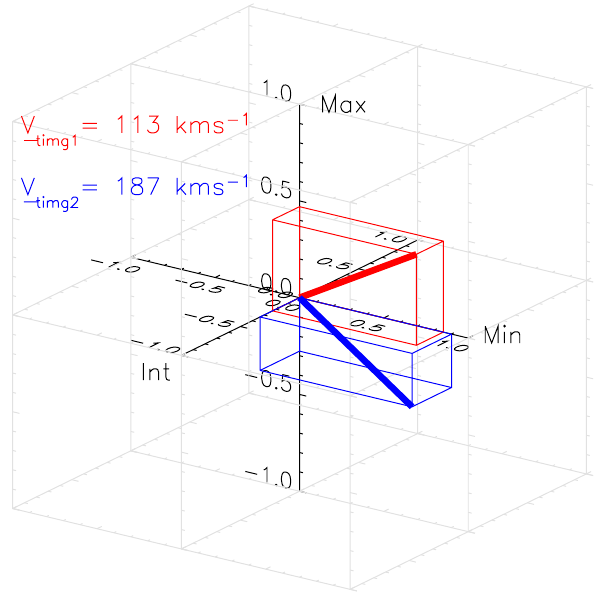
Fig. 6. A 3-D view of the variance frame with V timg vectors pro- duced from constant flux surfaces on 2 October event. The direc- tions “Min”, “Int” and “Max” correspond to the minimum, interme- diate and maximum variance directions plotted in GSM unit space in Fig. 4.